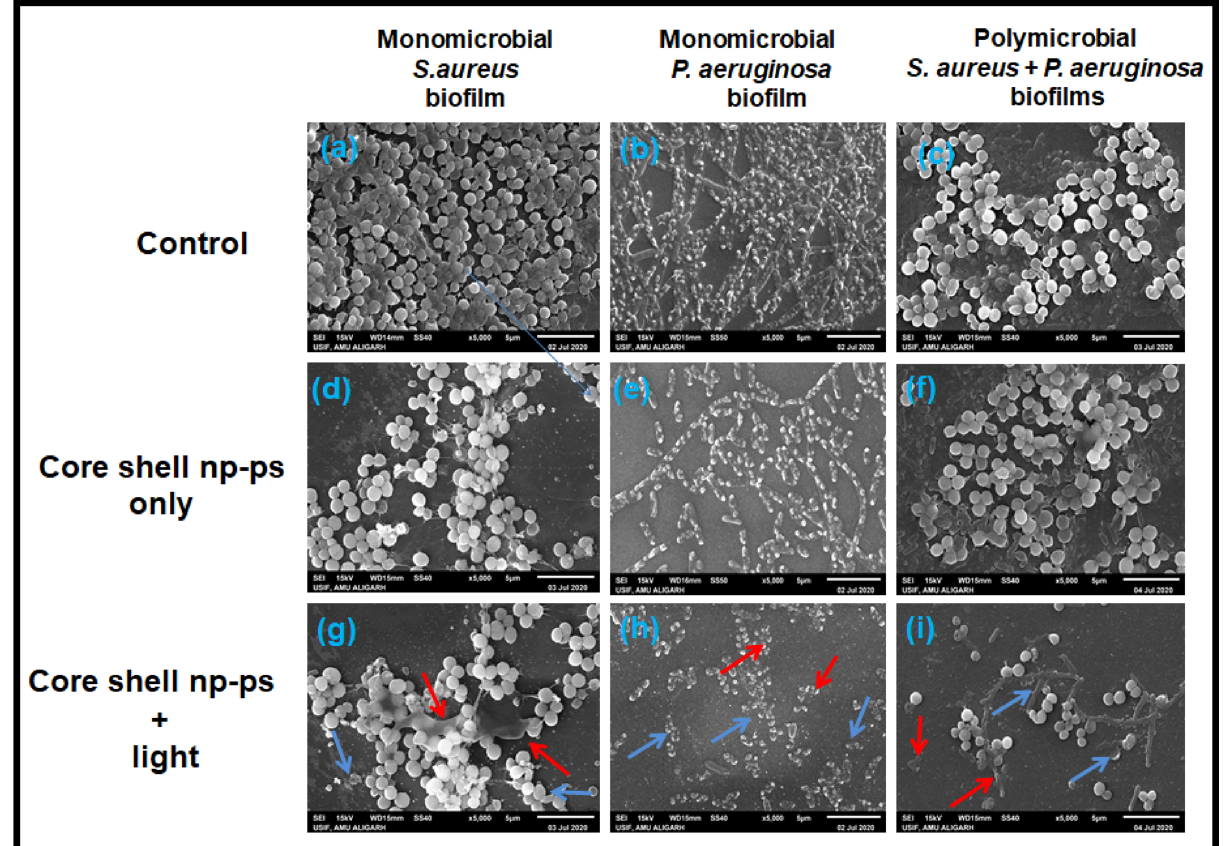
Figure 8. Scanning electron microscopy (SEM) images of monomicrobial S.aureus , monomicrobial P. aeruginosa and polymicrobial S. aureus + P. aeruginosa biofims of control ( a )–( c ), TBO–chit–Au–AgNPs treated ( d )–( f ) and TBO–chit–Au–AgNPs + laser treated ( g )–( i ). 630 nm laser (100 J/cm 2 , 12 min and 50 s) were used in the corresponding laser group. Red arrow indicates bursting and release of cellular constituents while blue arrow indicates complete rupturing of the